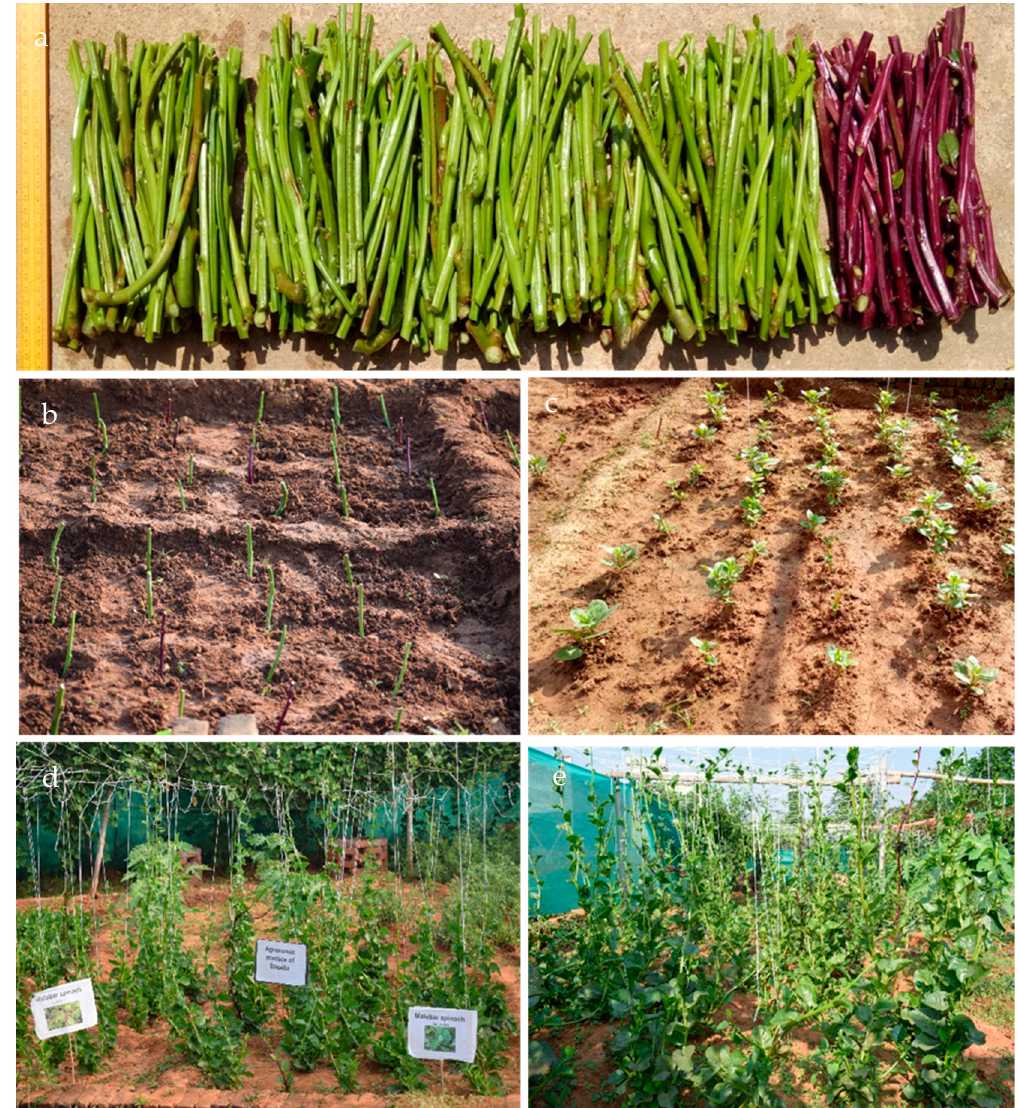
Figure 6. Optimization of agronomic practices and mass multiplication strategies are essential for the large-scale exploitation of underutilized crops. Photographs ( a – e ) shows the various stages of the mass propagation and cultivation of Indian spinach ( Basella alba and Basella rubra ).